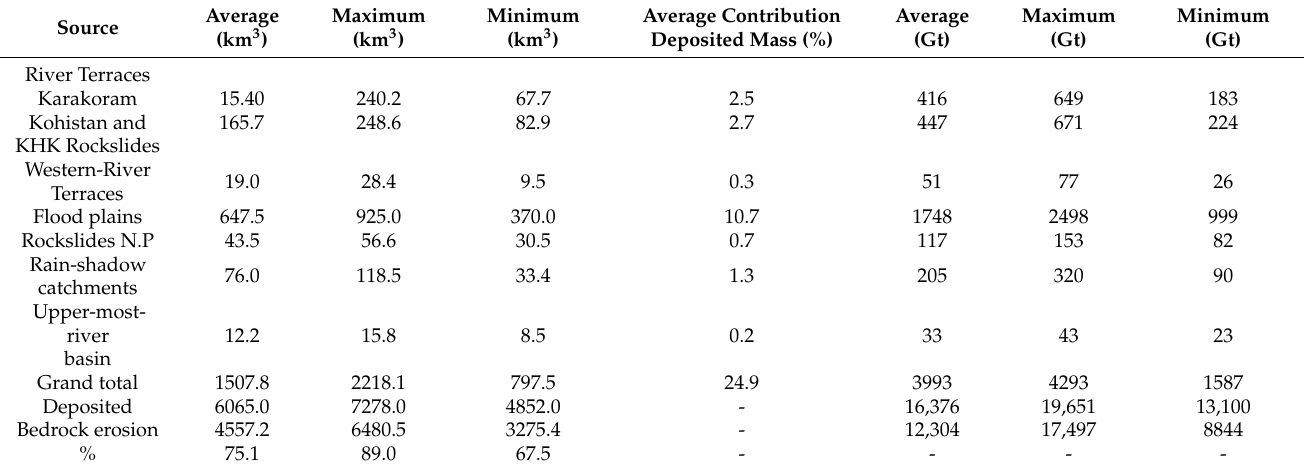
Table 1. Summary of the volumes eroded along the major rivers of the Karakoram, Hindu Kush and Kohistan rock landslide. Source